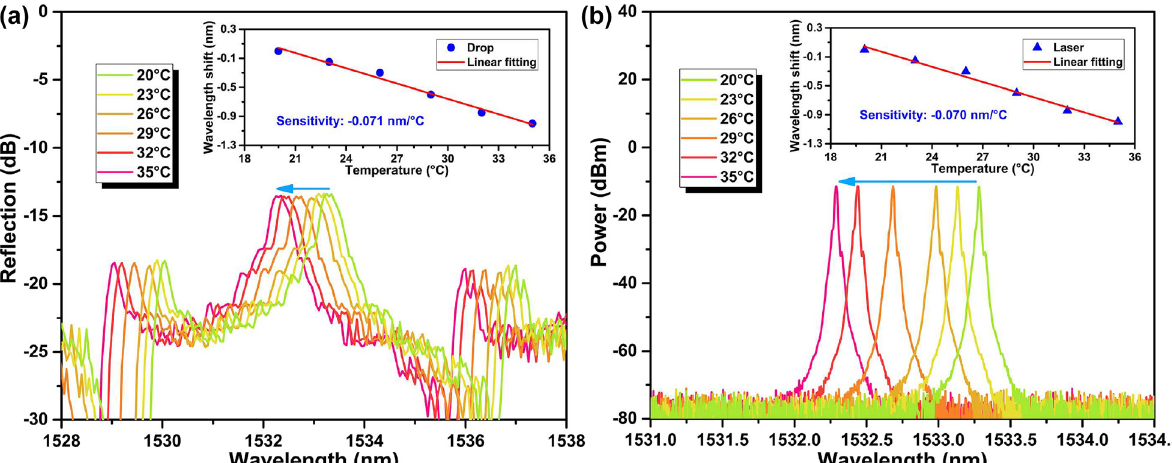
Figure 6: Active interrogation with lasing